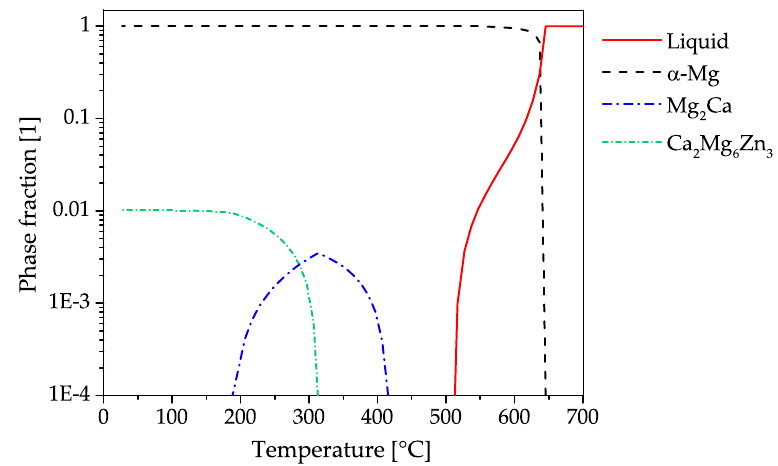
Figure 28. CALPHAD calculations (for further information see Appendix A) of ZX10 in a temperature range of 25 to 700 ◦ C, showing phase fractions of 10 − 4 to